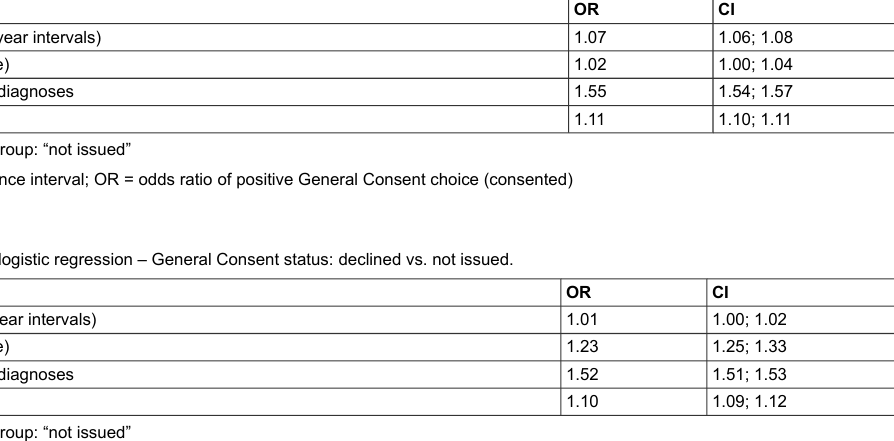
Table 1: Multinomial logistic regression – General Consent status: consented vs. not issued. Variable